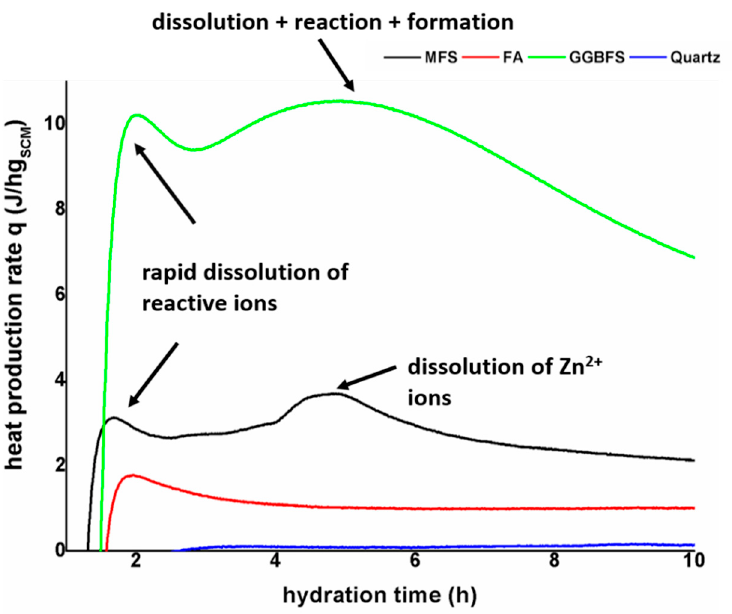
Figure 2. Calorimetric analysis of the R 3 model paste for initial 10 h.